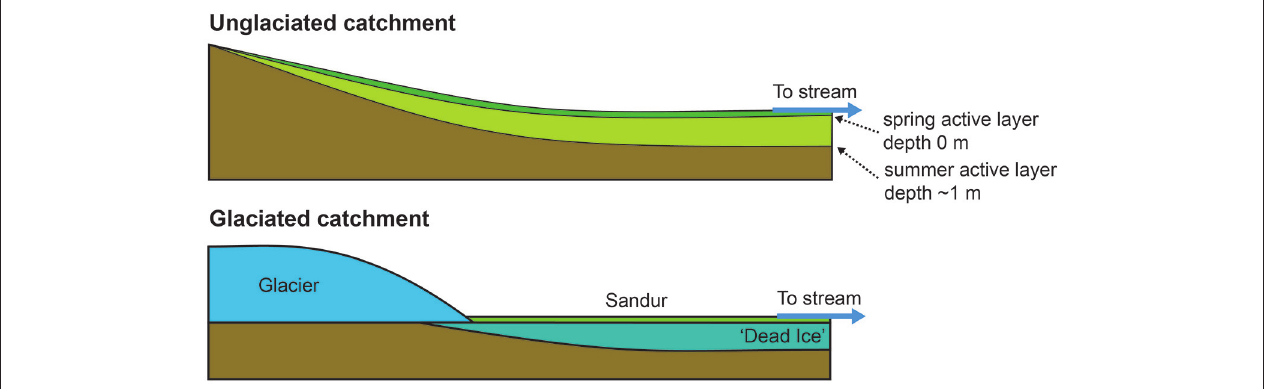
FIGURE 5 | Schematic of the landscape controls on δ 7 Li and ( 234 U/ 238 U) ratios. Unglaciated: Typical permafrost profile with a seasonal active layer which deepens from spring to summer. Water-rock reaction is low in spring and increases as the melt season progresses. Active layer depths are taken from the Gruvefjellet borehole situated 5 km from this catchment at comparable altitude (Etzelmüller et al., 2011). Glaciated: In contrast to the unglaciated catchment, the dead ice prevents downward expansion of the thawed layer and only a a thin layer of sediment is exposed to weathering. Water-rock reaction time remains low and relatively constant throughout the melt